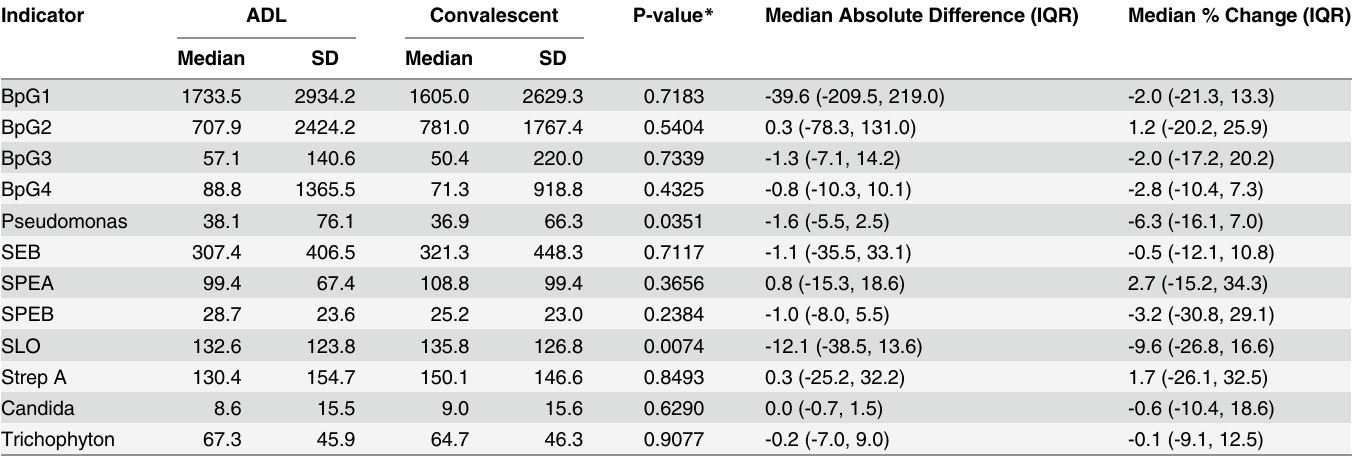
test, only Pseudomonas (P-value = 0.0351) and SLO (P-value = 0.0074) showed a significant result. The median difference between paired ADL and convalescent time points ranged from -39.6 for BpG1 to 0.8 for SEB. The median % change between paired ADL and convalescent time points of greatest magnitude was seen for the SLO antigen (-9.6%). The median % change of smallest magnitude was for Trichophyton (-0.1%). SPEA had the greatest positive percent change (2.7%). Although the median % changes are minimal, the IQRs for each antigen are